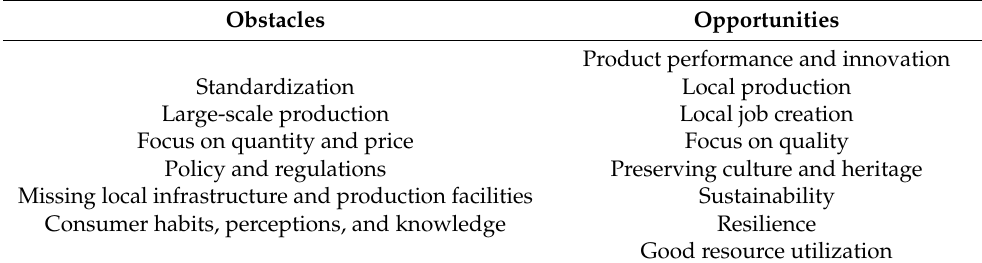
Table 5. Overview of obstacles and opportunities for coarser wool in consumer